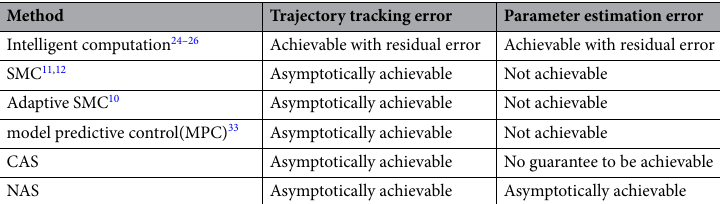
Table 2. Comparison of several existing methods and the proposed